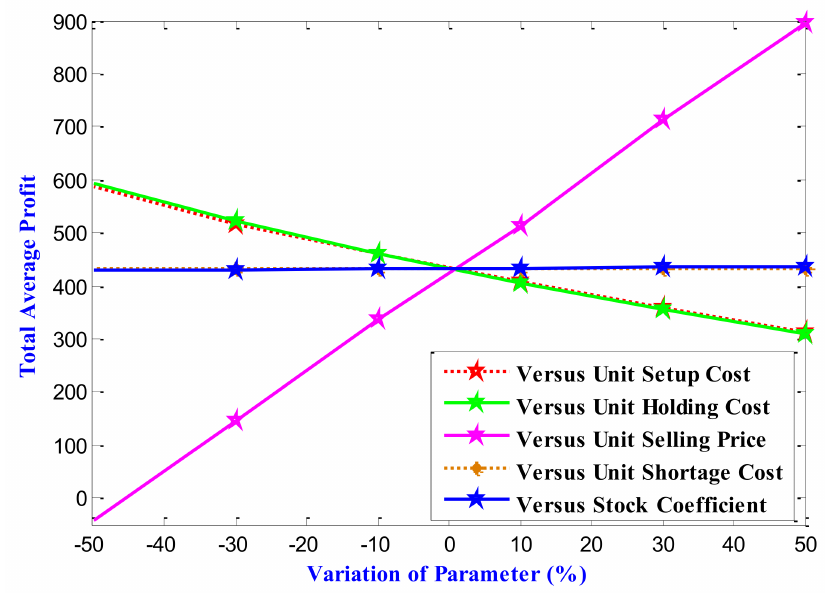
Figure 12. Graphs of the sensitivity analysis on optimum values of the objective function total average profit ( TAP ∗ ) for the model with shortage with respect to the input variables ( S up , h c , p , s c , c ) varying them from − 50% to +50% of their